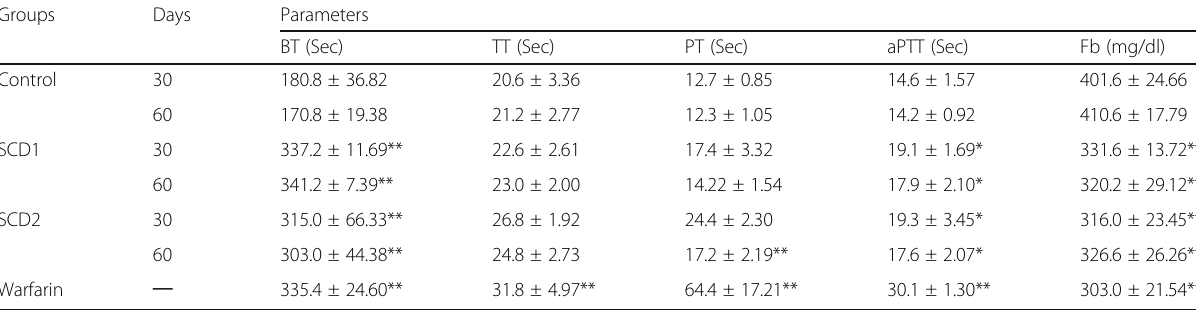
Table 1 In vivo comparison of Syzygium cumini leaves extract, warfarin and control on rabbit ’ s coagulation parameters. Humaclot duo coagulometer and human reagent kits were used to perform these tests. Clot formation was evaluated by turbidimetric technique